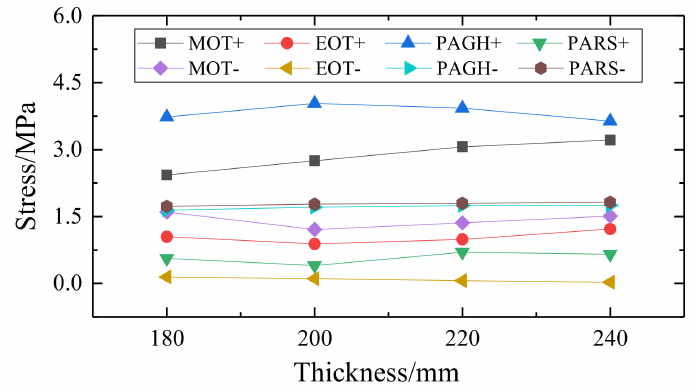
Figure 21. Influence of thickness on temperature stress of track slab (In legend identification, “+” means positive temperature gradient; “ − ” means negative temperature gradient).